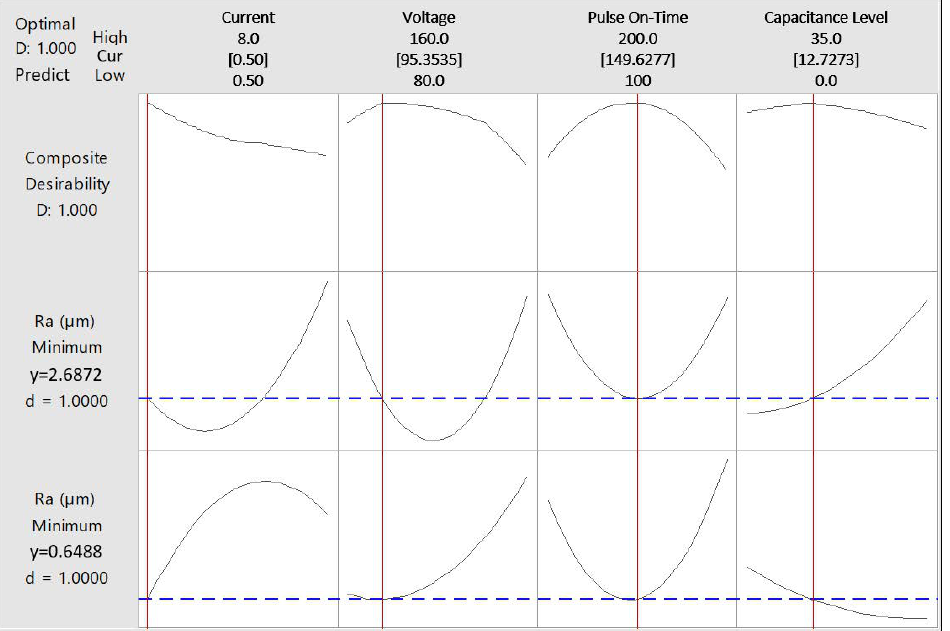
Figure 7. Combination of machining parameters reducing Ra in both reinforcement